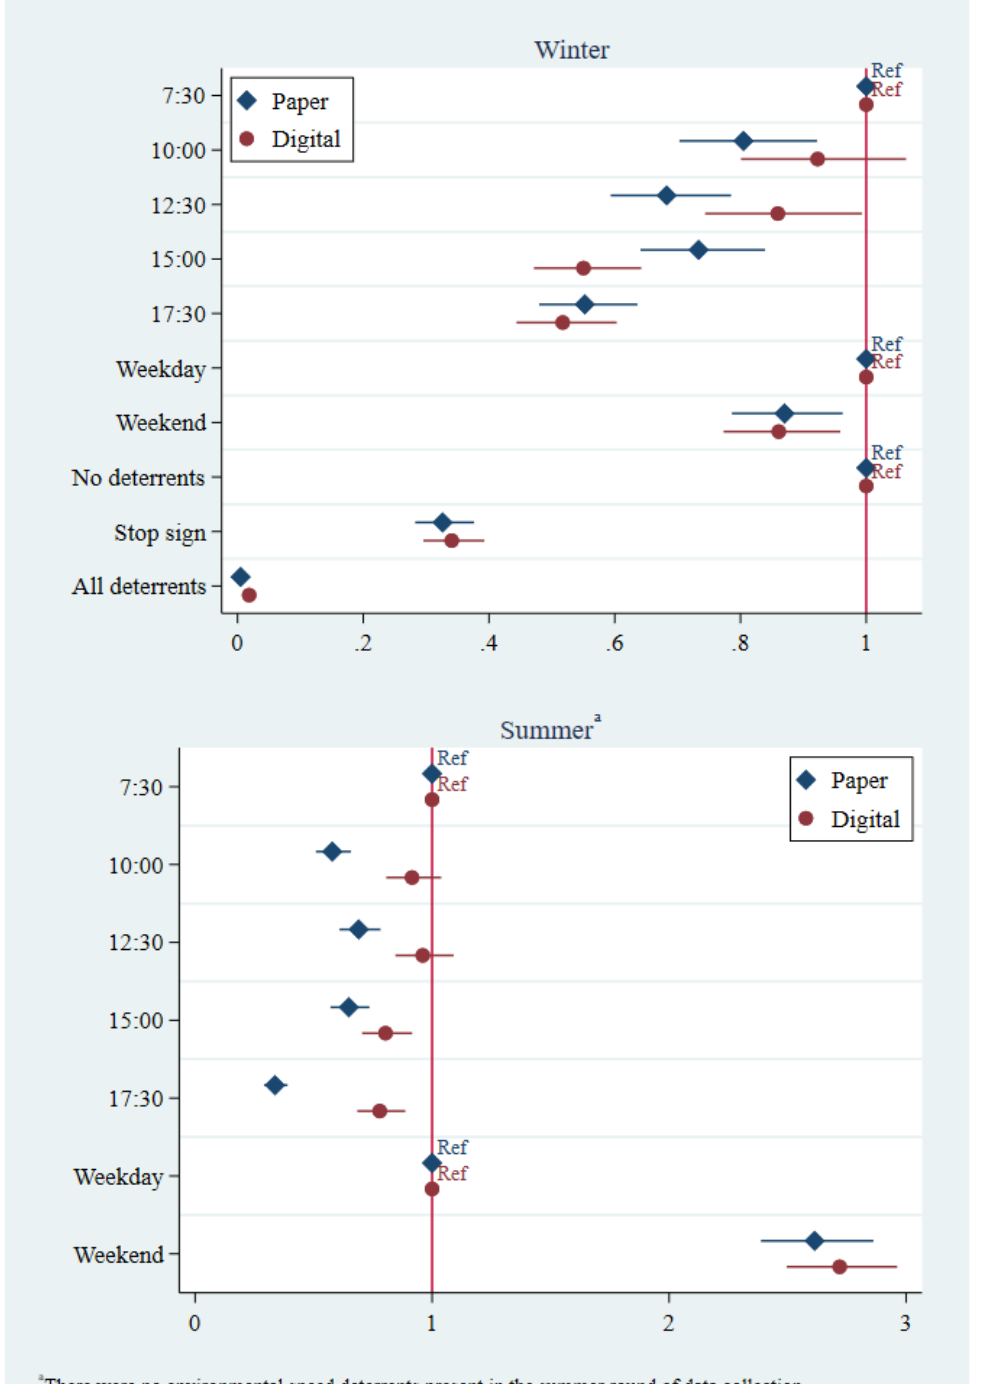
Figure 6. Speeding: adjusted odds ratios by data collection method and